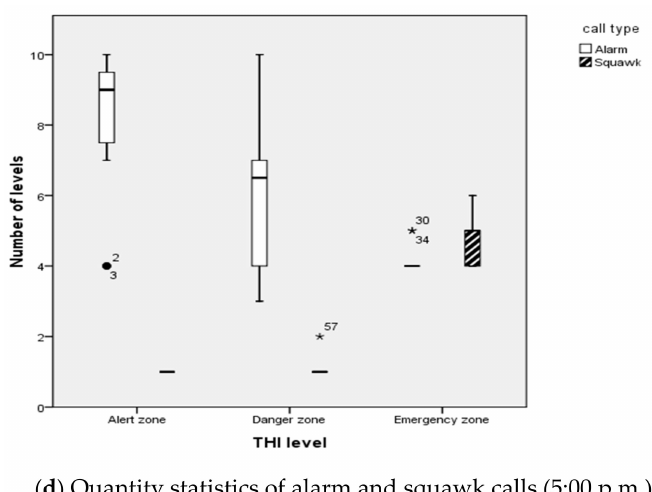
Figure 6. The number of levels of hen calls in di ff erent thermal environments. Alert zone (THI 70–75), danger zone (THI 76–81), and emergency zone (THI > 81). The number of levels axis indicates the normalised range (from level 1 to level 10) of call quantity per five minutes.